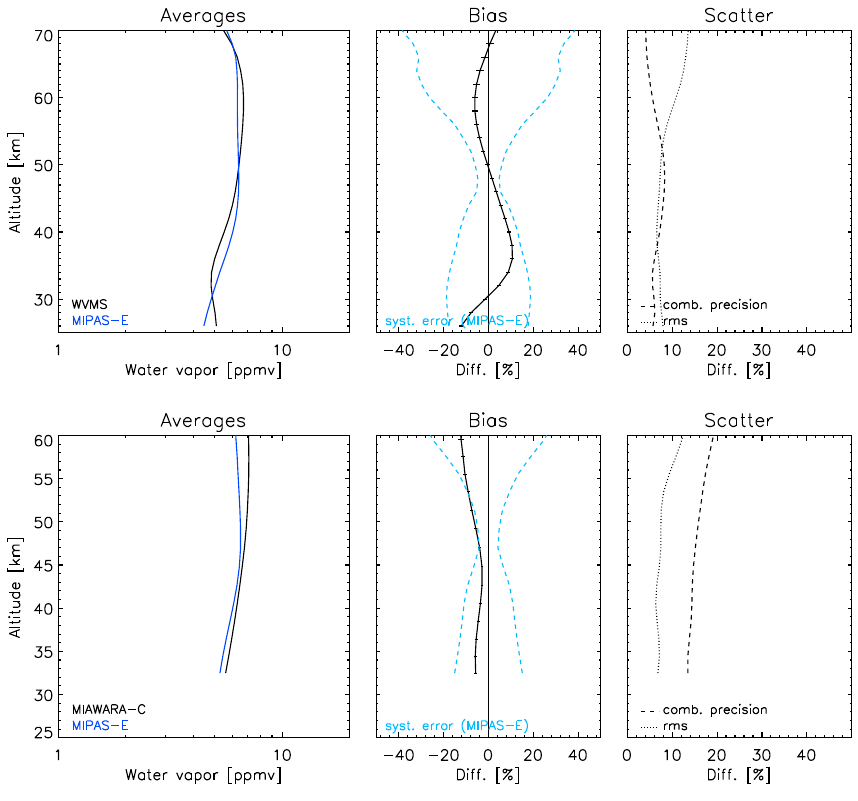
Fig. 12. Same as Fig. 9 but for WVMS (top row) and MIAWARA-C (bottom row) microwave radiometer water vapor profiles (6 hrs measurement time). For a more detailed description see Fig. 9.